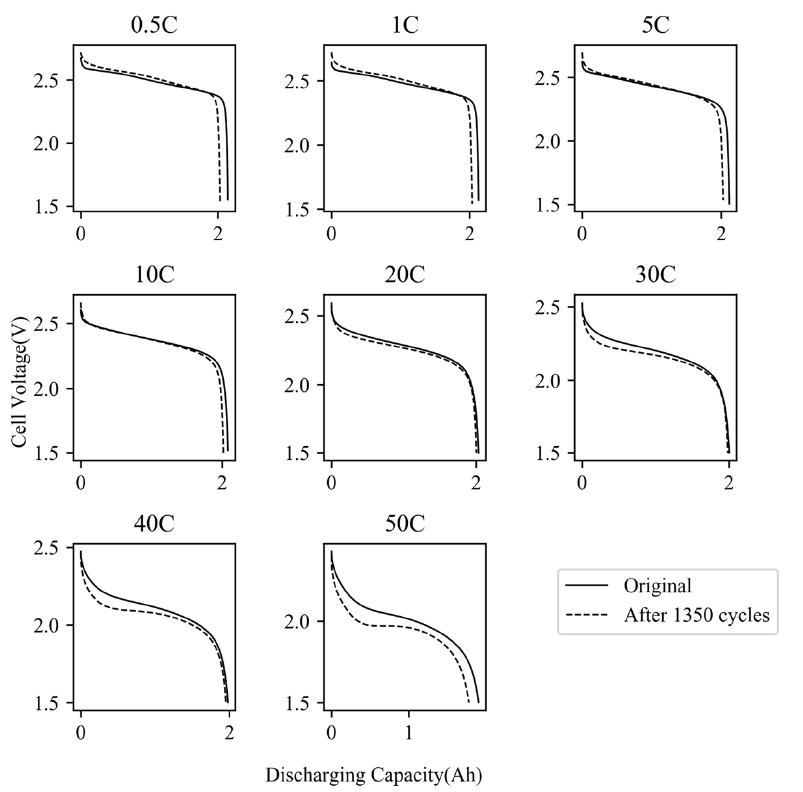
Figure 4. Discharging curves at all current rate of cell #7 before and after aging cycles.